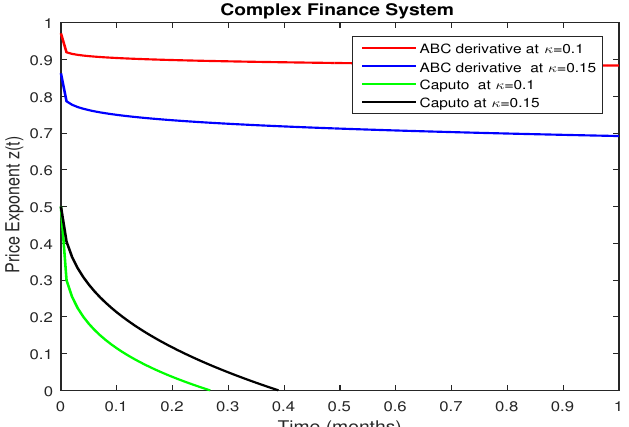
Figure 9. z ( t ) price exponent with Caputo and ABC